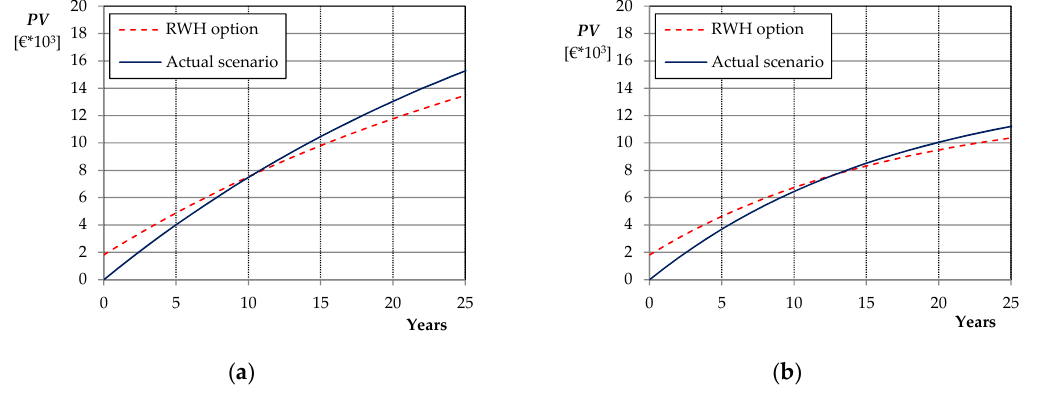
Figure 9. Curve of present value PV for A = 160 m 2 ; 4-apartment building with average total daily demand for toilet flushing D = 0.575 m 3 /day; S = 3 m 3 ; f = 0.5; N = 25, and for ( a ) r = 3%; ( b ) r = 6%.